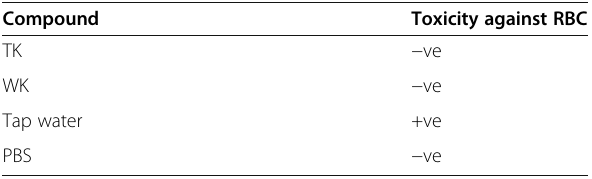
Table 7 Cytotoxicity test of killer toxins in concentration 0.2 g/